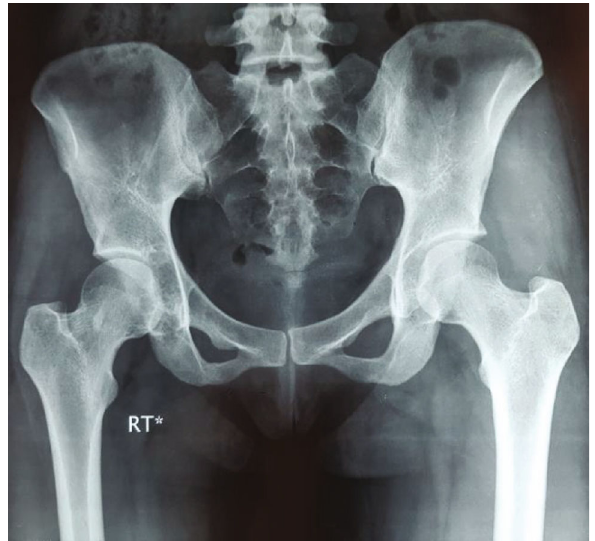
Figure 1: Preoperative anteroposterior pelvic X-ray of a 31-year-old female shows narrowing of joint space and cortical erosions and lucency in the acetabulum and femoral head of the right